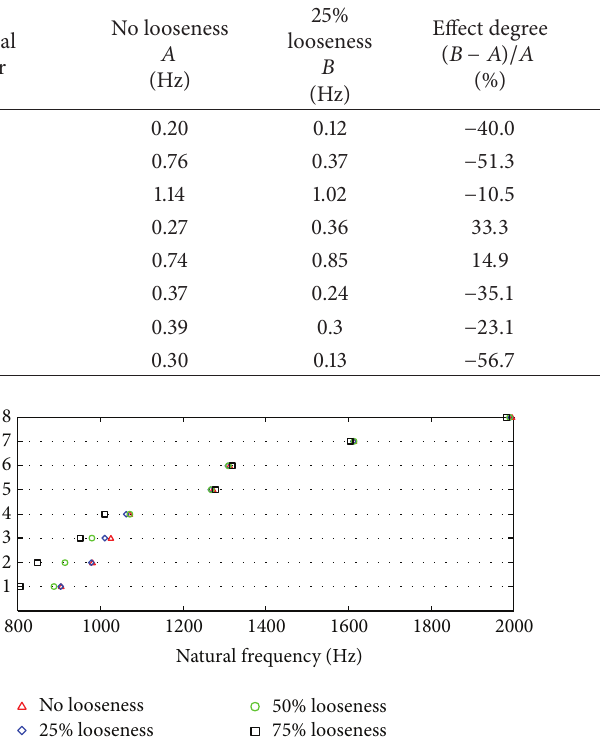
Figure 14: Scattergram of natural frequencies of TCS under BLB with different looseness levels.